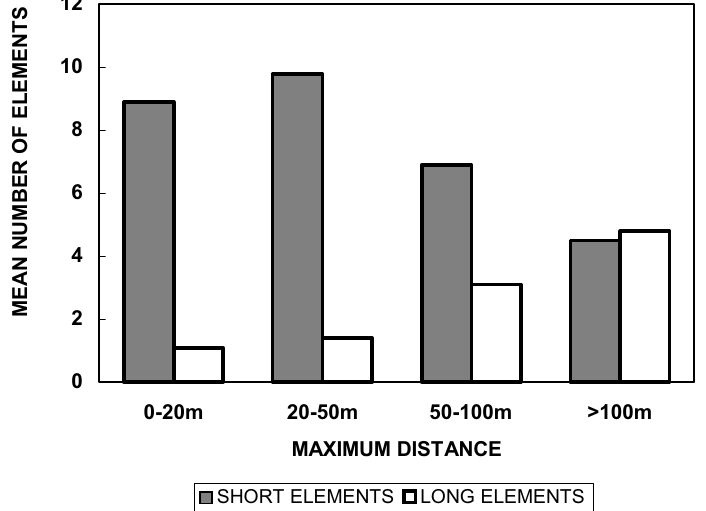
Fig. 3 – Mean number of short and long elements in calls performed at the four classes of maximum distance of participants relative to the focal caller.